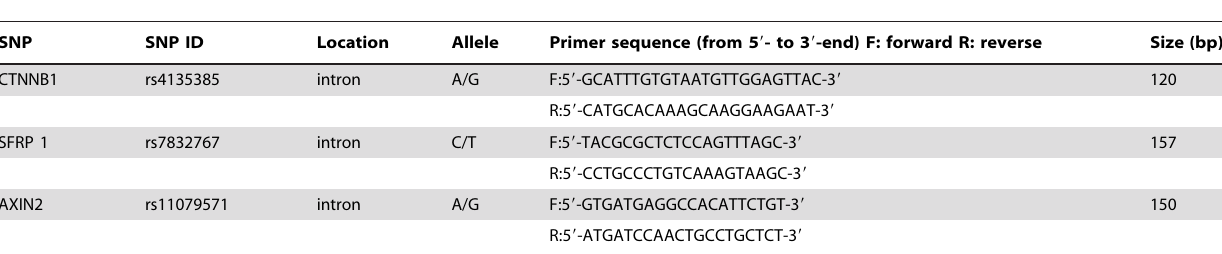
Table 1. Primer sequences for the three SNPs genotyping.